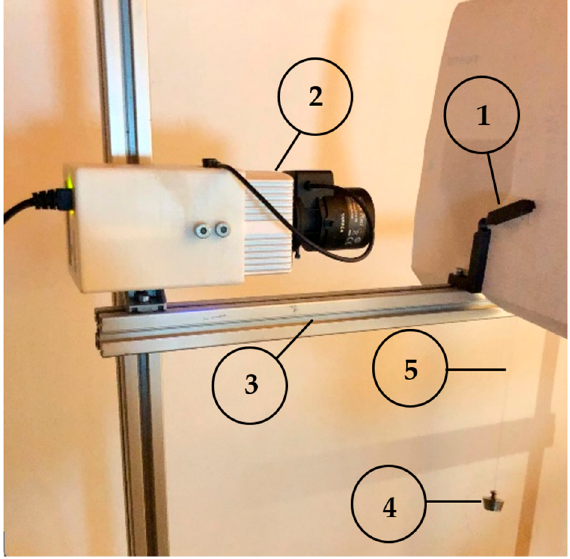
Figure 7. Experimental setup for vision-based measurement of the bending angle range of 3D-printed finger. ( 1 ) 3D-printed finger. ( 2 ) Camera. ( 3 ) Supporting structure. ( 4 ) Load. ( 5 ) Thin nonelastic string.